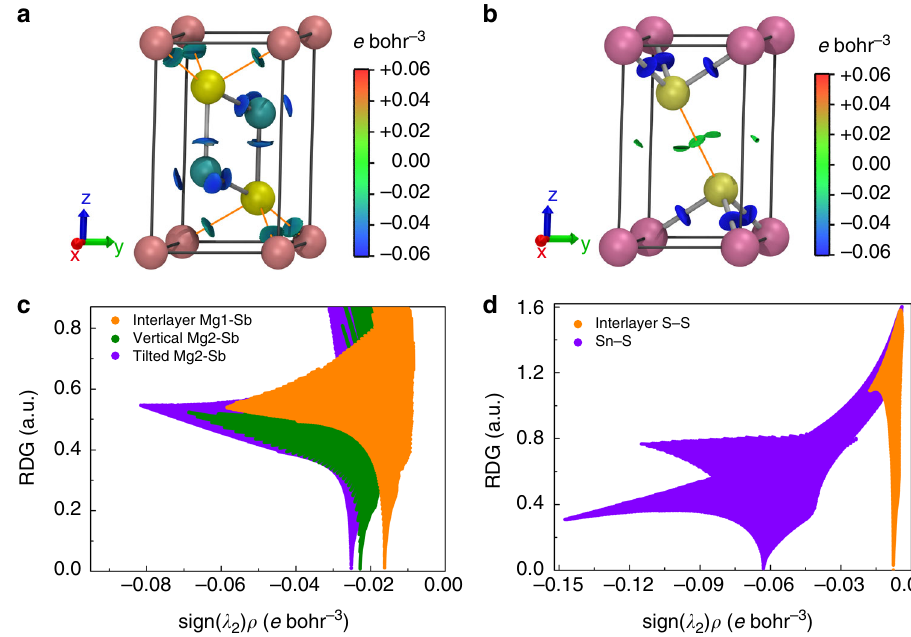
Fig. 2 Non-covalent interaction analysis. a , b 3D non-covalent interaction plot for ( a ) Mg 3 Sb 2 and ( b ) SnS 2 . The RDG isosurface corresponds to RDG = 0.24 a.u., which is colored on a BGR scale of − 0.06 < sign( λ 2 ) ρ < 0.06 e bohr − 3 . c , d RDG as a function of sign( λ 2 ) ρ for the interlayer and intralayer interactions in ( c ) Mg 3 Sb 2 and ( d ) SnS